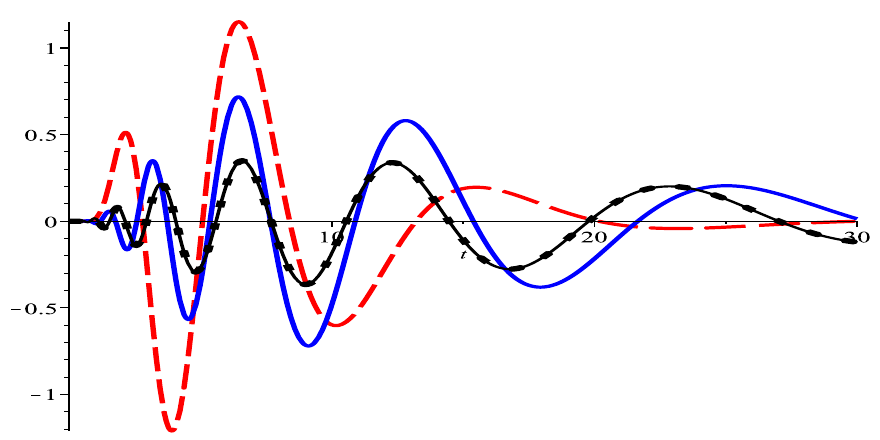
Figure 1. Three Flat Functions: Normalized plots of first-order MADE solutions that are flat at t = 0, (1) f 1,2 ( t ) (dashed red), (2) f 1,4 ( t ) (solid blue), (3) f 1,6 ( t ) (dotted black line) all for q =